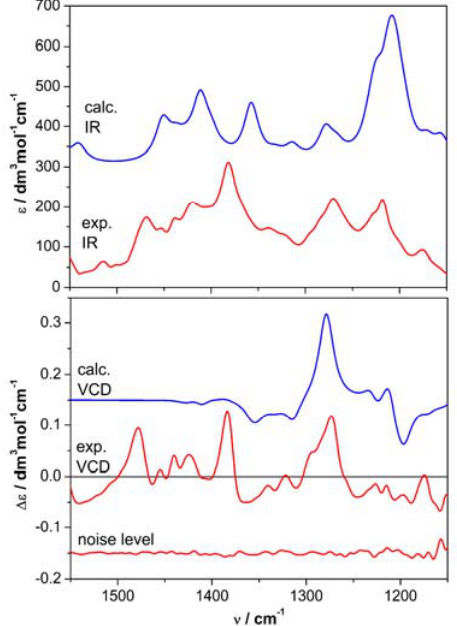
Figure 4. Comparison of experimental and calculated IR/VCD spectra for ( R ) ‐ 1 . Measurement run on 16 mM solution in CD 3 OD, 100 μ m BaF 2 cell. Calculations run at ω B97X ‐ D/6 ‐ 311+G(d,p) level including PCM solvent model for MeOH; Boltzmann averaged over three conformers; plotted as sum of Lorentzian functions with 10 cm –1 half ‐ width at full maximum and frequency scale factor 0.948. 9 ‐ O ‐ methylfusarubin ( 1 ) showed bactericidal activity against some Gram+ bacteria while it was